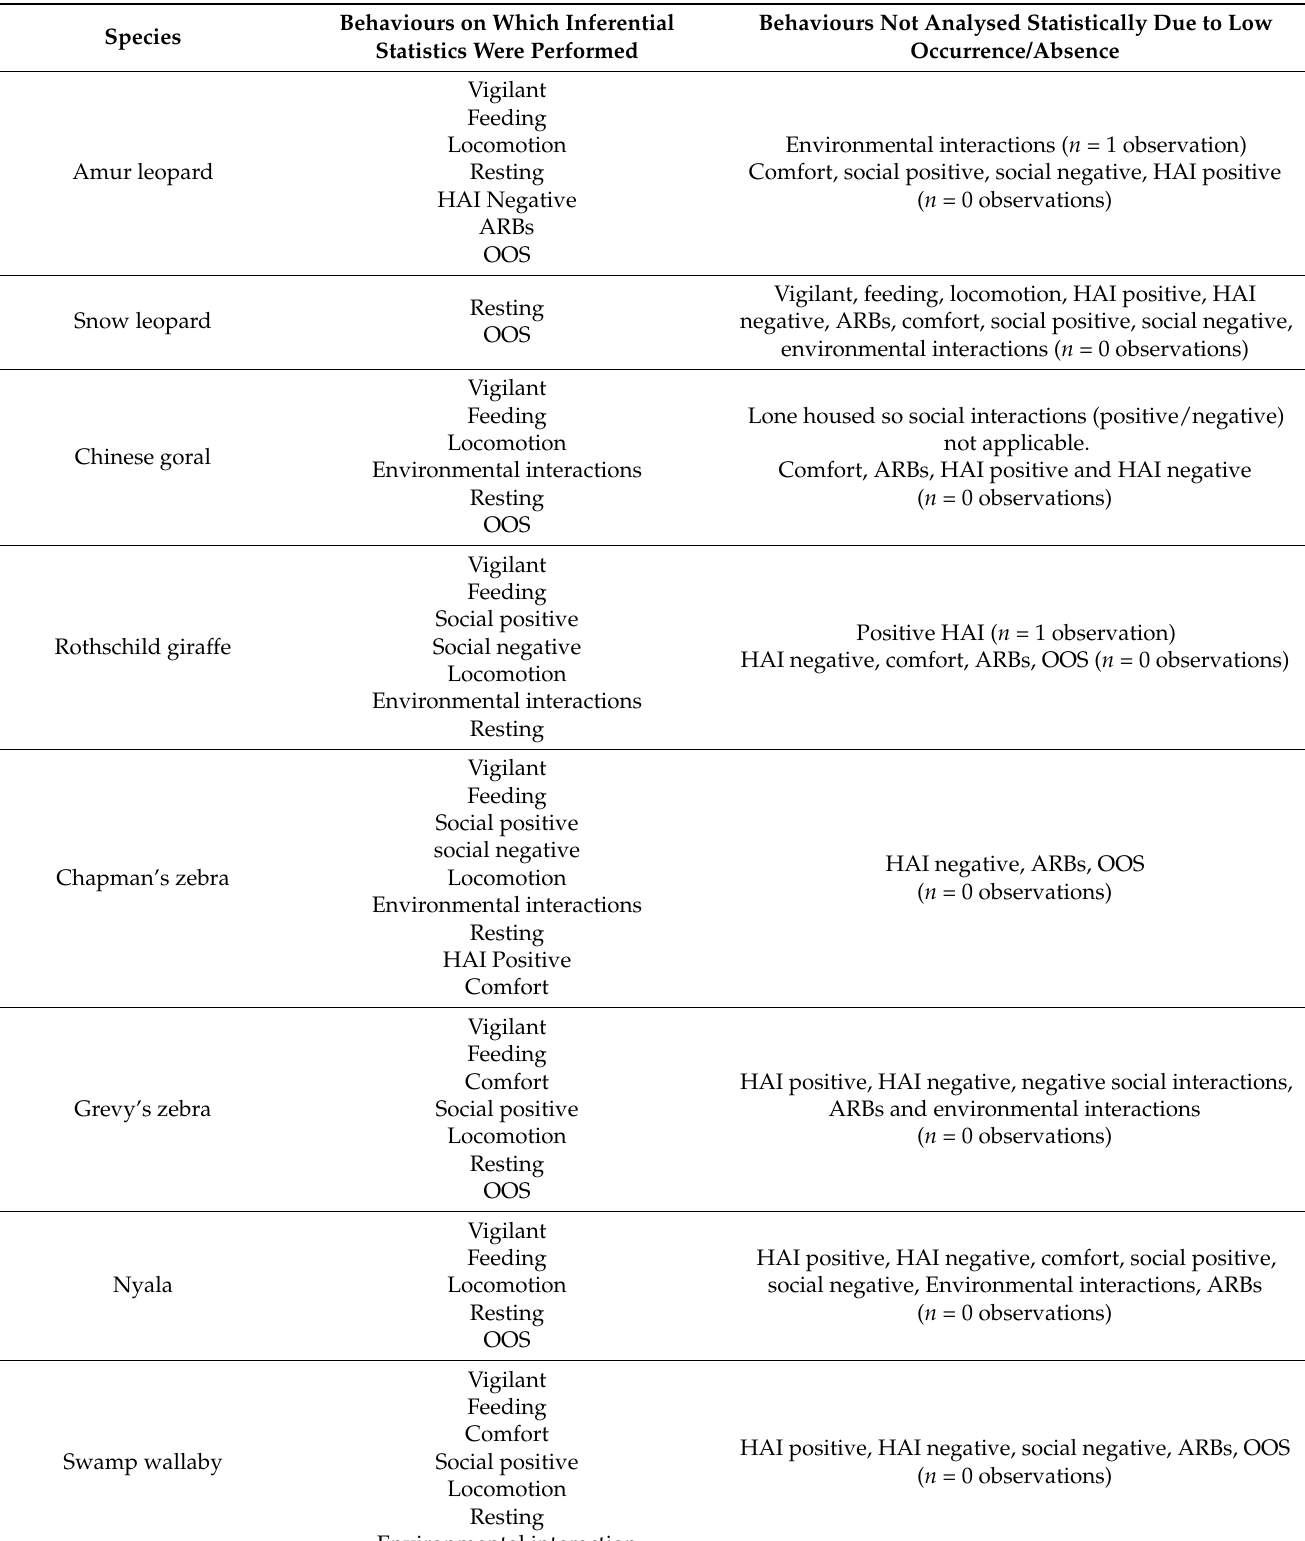
Table 3. An overview of behaviours recorded per species and inferential statistics